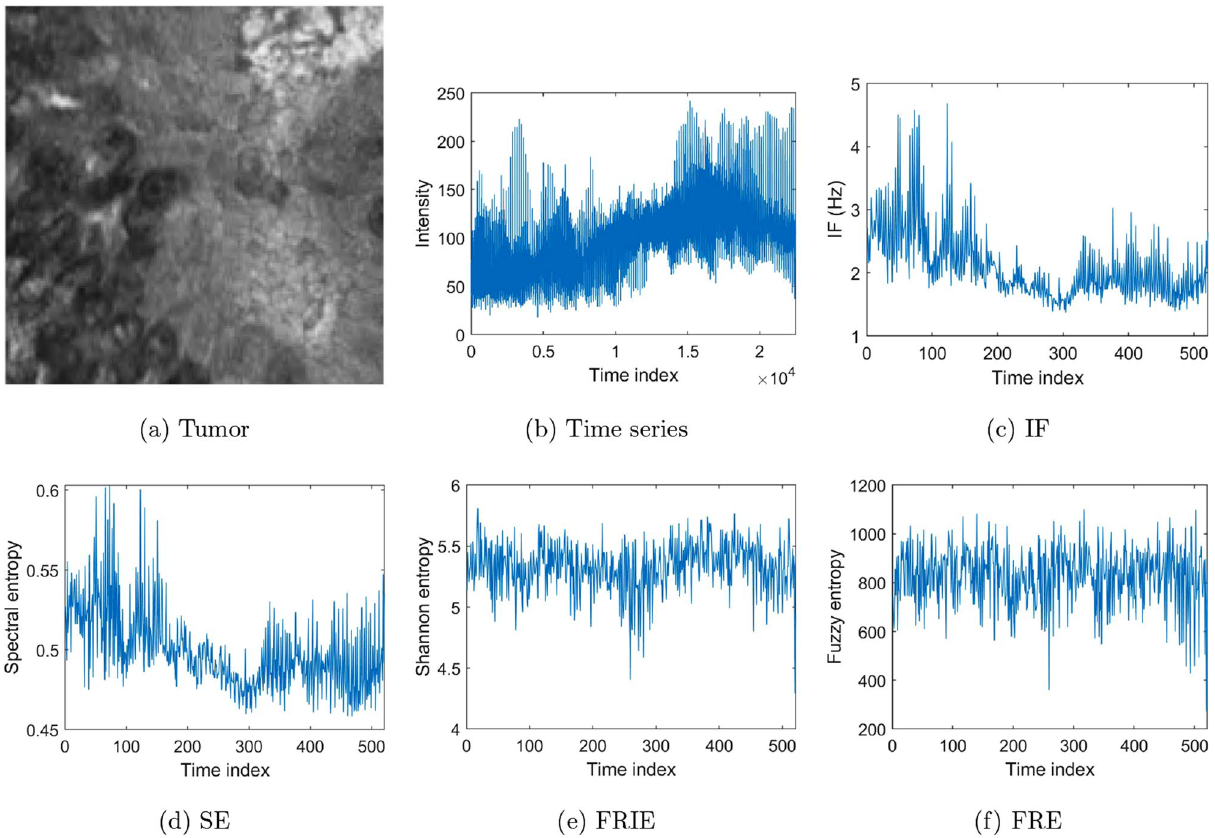
Figure 5. Time-frequency and time-space features extracted from time series of a grayscale image of H&E tumor tissue of colorectal